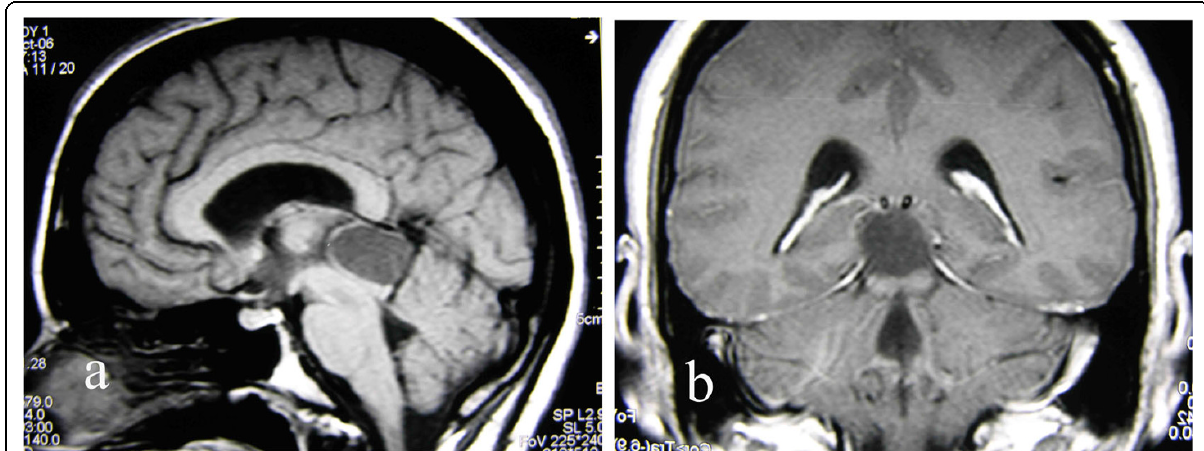
Figure 1 Pre-operative MR images illustrating the presence of a cystic lesion located in the pineal region